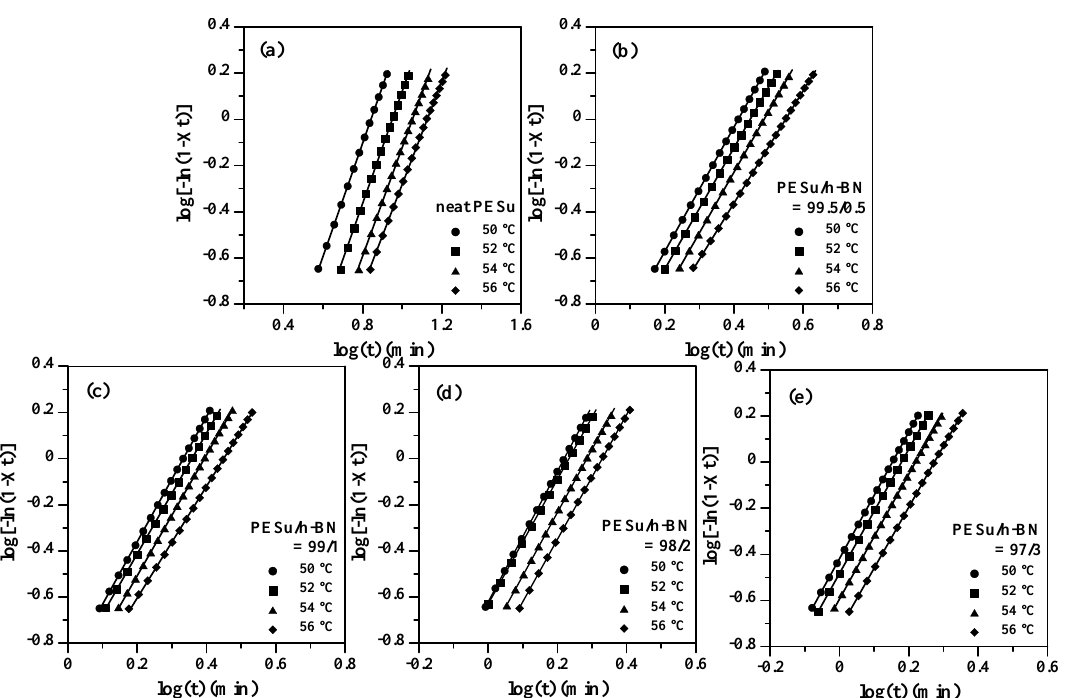
Figure 4. The Avrami plots for isothermal crystallization for various PESu/h-BN composites: ( a ) 100/0; ( b ) 99.5/0.5; ( c ) 99/1; ( d ) 98/2; and ( e ) 97/3.